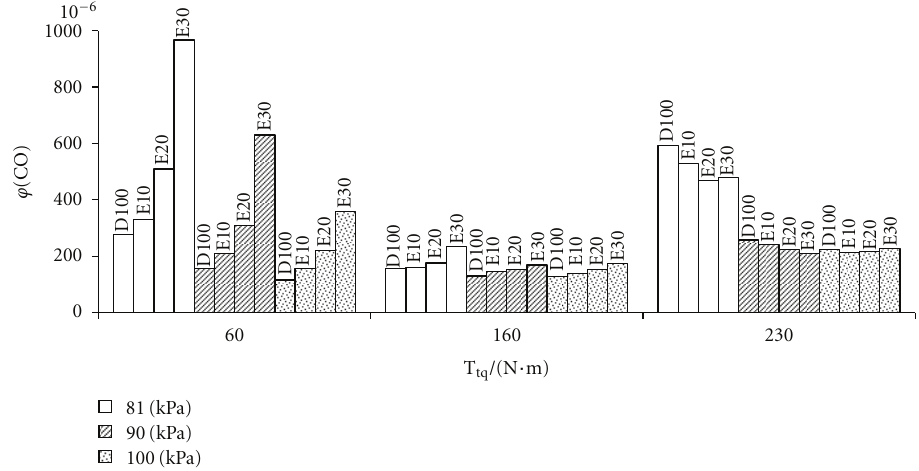
Figure 6: Comparison of CO emission of di ff erent atmospheric pressure and mix proportion at speed 2200r/min.